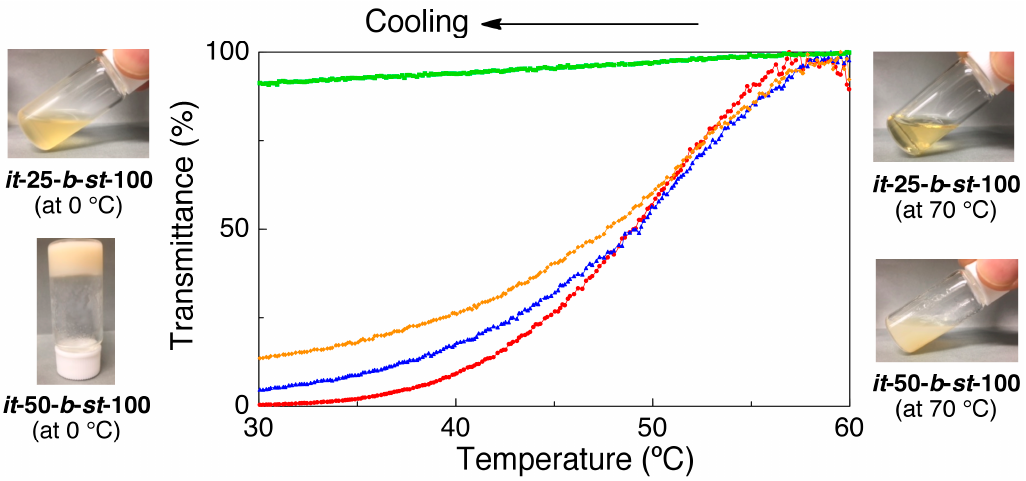
Figure 7. Relative transmittance (wavelength = 500 nm) of a series of SEC curves of solutions of it - b - st -stereoblock PMMAs in CH 3 CN (100 mg/mL) with varying temperatures at cooling rate of 1 °C/min: Orange, it -25- b - st -50; Green, it -25- b - st -100; Blue, it -50- b - st -50; Red, it -50- b - st -100.